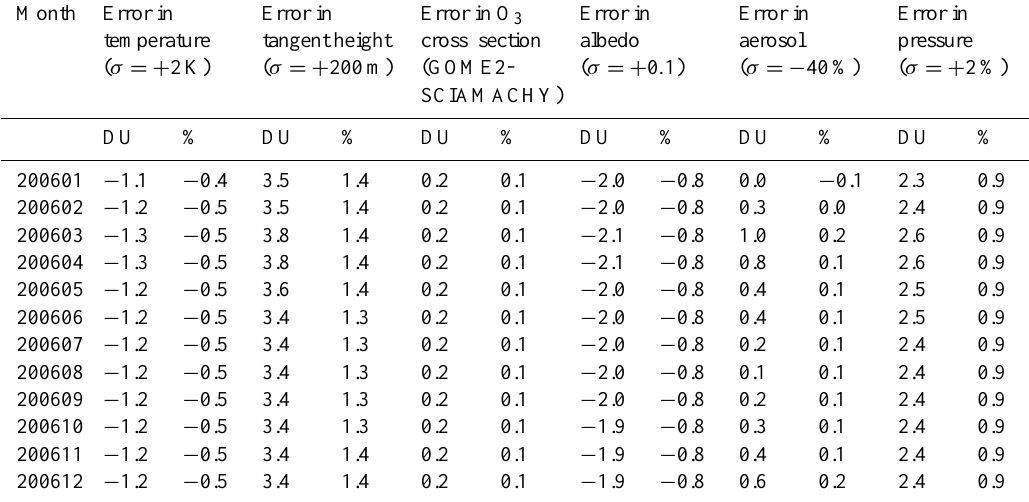
Table 2. Monthly average of global SOC retrieval parameter errors in 2006, σ is the assumed parameter uncertainty. Month Error